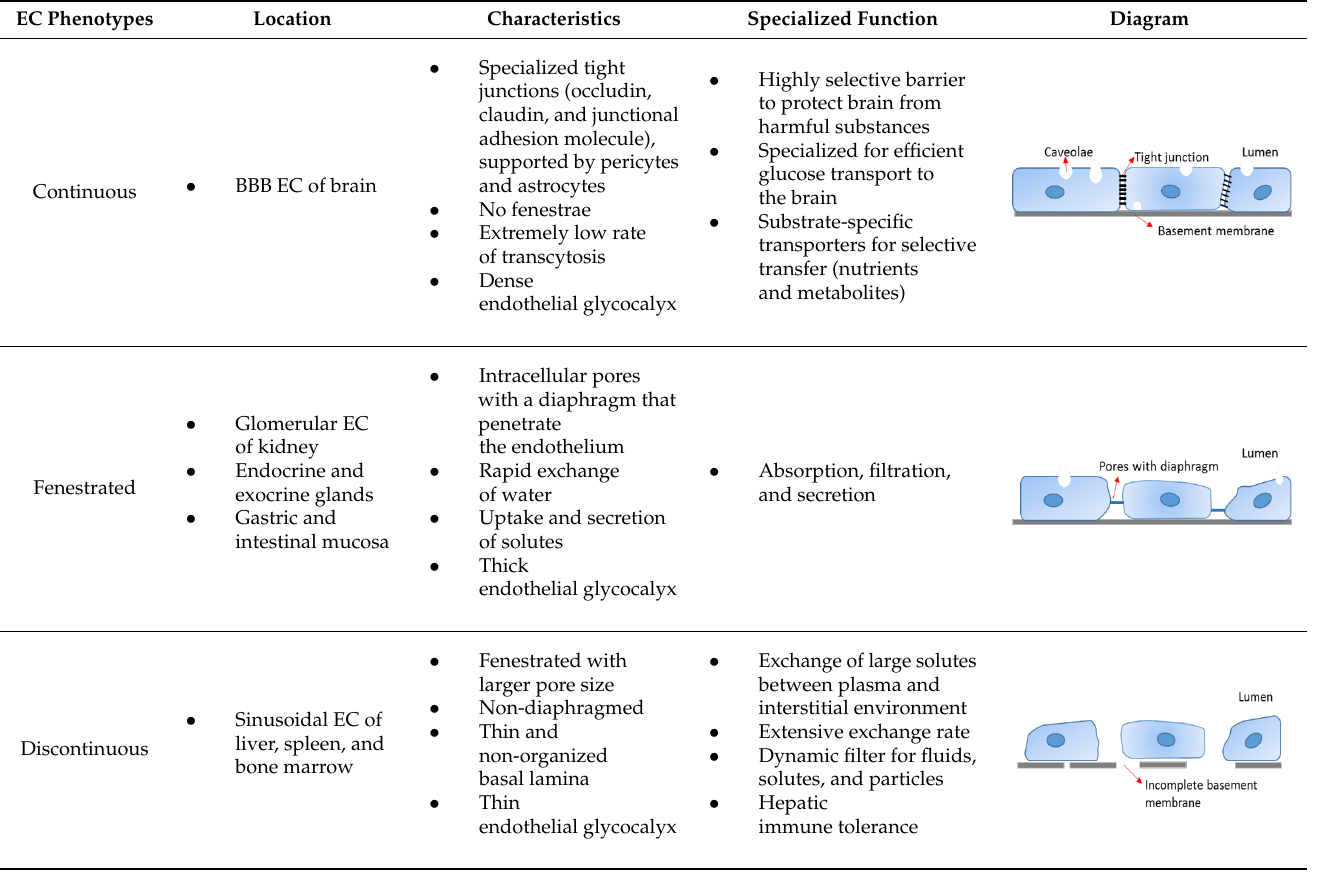
Table 1. Examples of endothelial cell heterogeneity across organs.